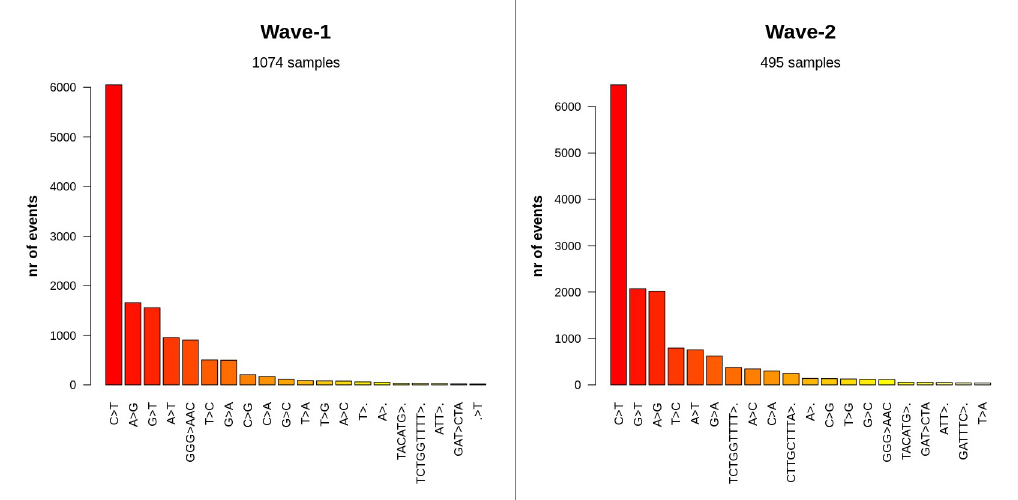
Fig 4. Most frequent mutational events per type between the two waves. The C to T transition was highly prevalent in both waves. While A to G transition is the second most abundant event in wave-1, samples from wave-2 had G to T transversion event.